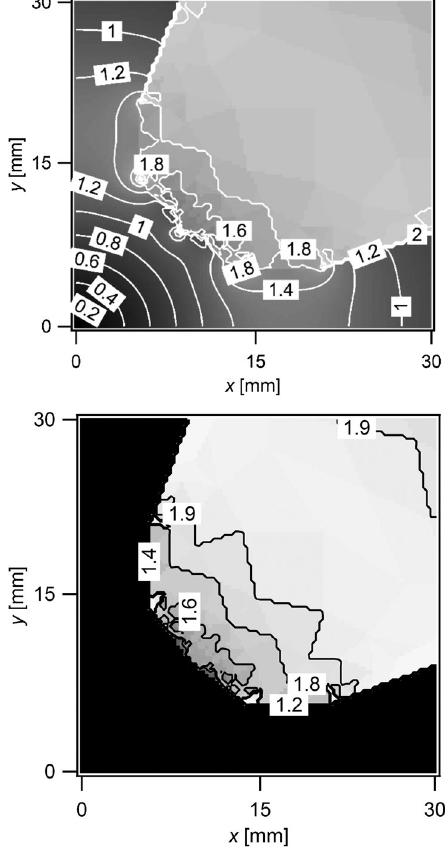
FIG. 11. Pole field B (top) and magnetization μ 0 M (bottom) at 90 A, with Profile 1. All values are in [T].